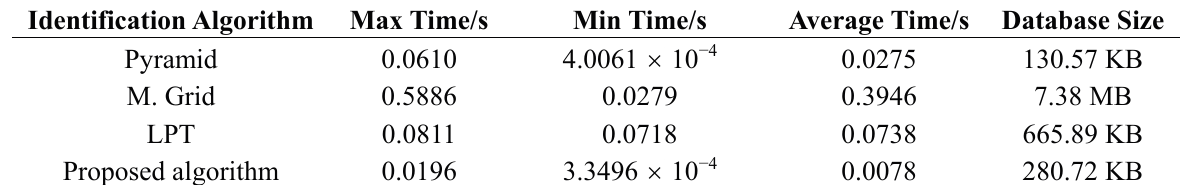
Table 1. Identification time and memory usage of different